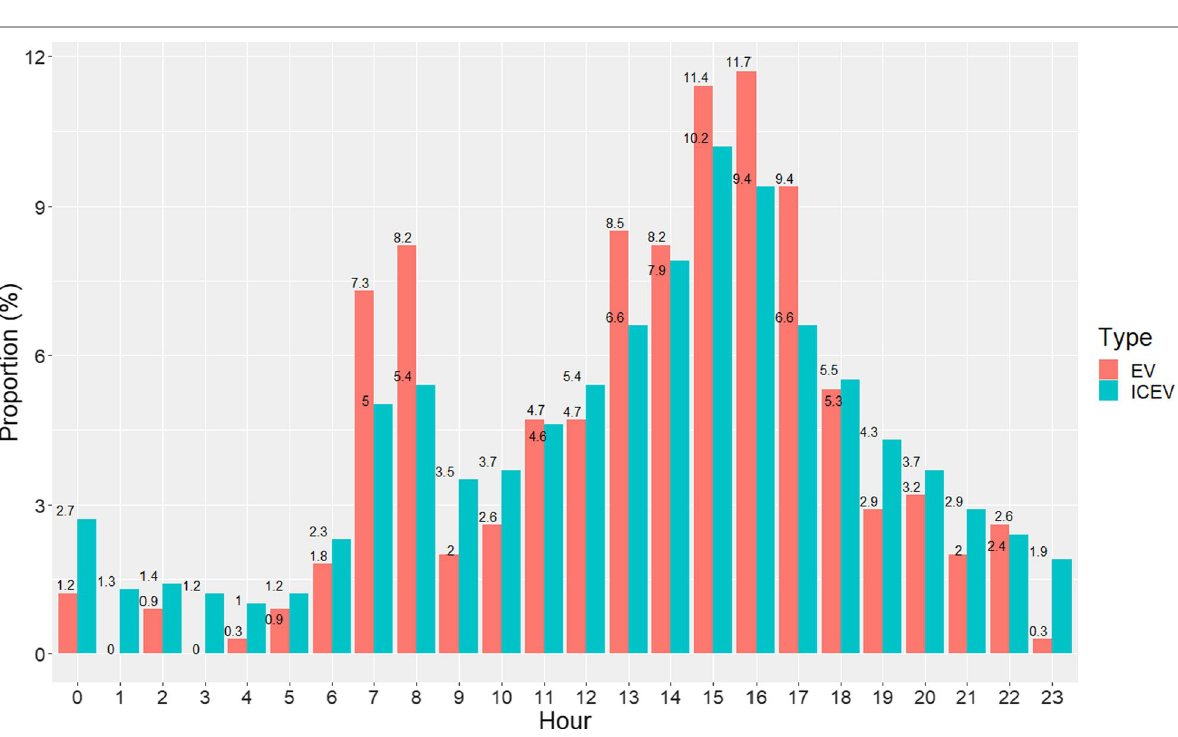
Fig. 4 Distribution of crashes by time of